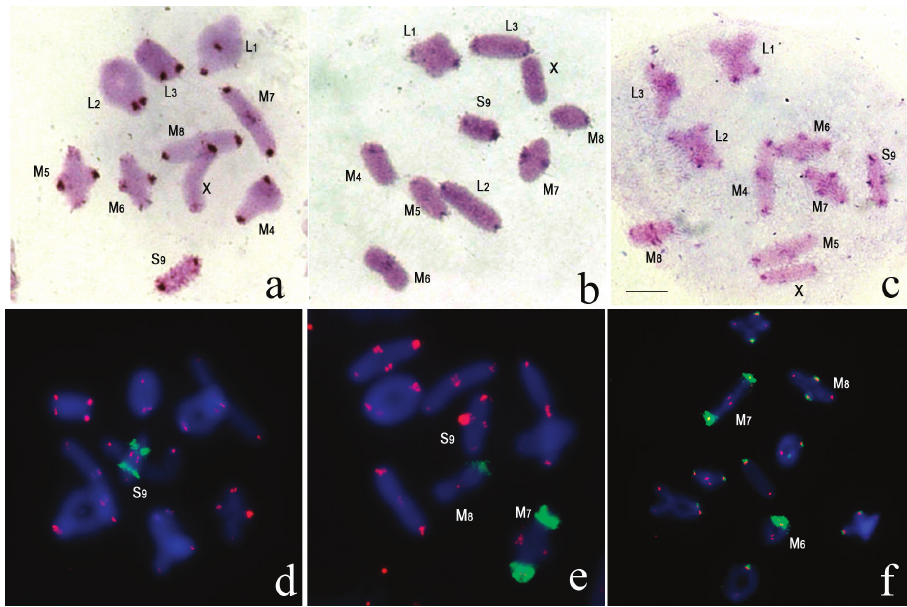
Figure 1. C-banding ( a–c ) and fluorescence in situ hybridization of 28S ribosomal DNA (green) and telomere (TTAGG) (red) probes ( d–f ) with chromosomes of: a, d Zonocerus elegans , metaphase I of n meiosis b, e Atractomorpha lata, metaphase I of meiosis c, f Pyrgomorpha guentheri, metaphase I of meiosis Bar = 5